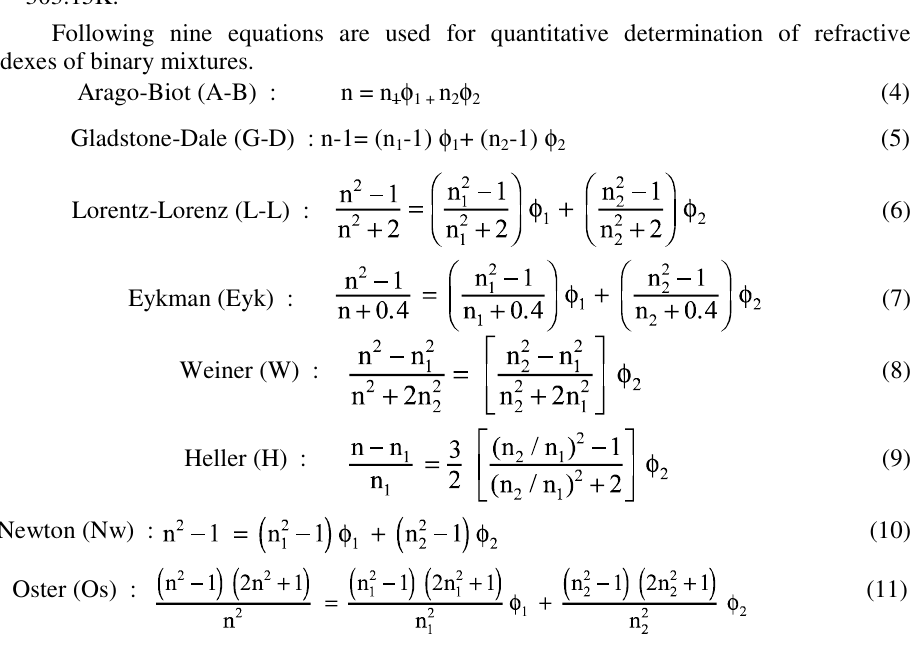
Figure 1. Excess Refractive Index (nE ) with mole fraction (x 1) for Eucalyptol(1) + o -Xylene(2) ( ∆ ), Eucalyptol(1) + m -Xylene(2) ( ∇ ), Eucalyptol(1) + Toluene(2) (  ) at